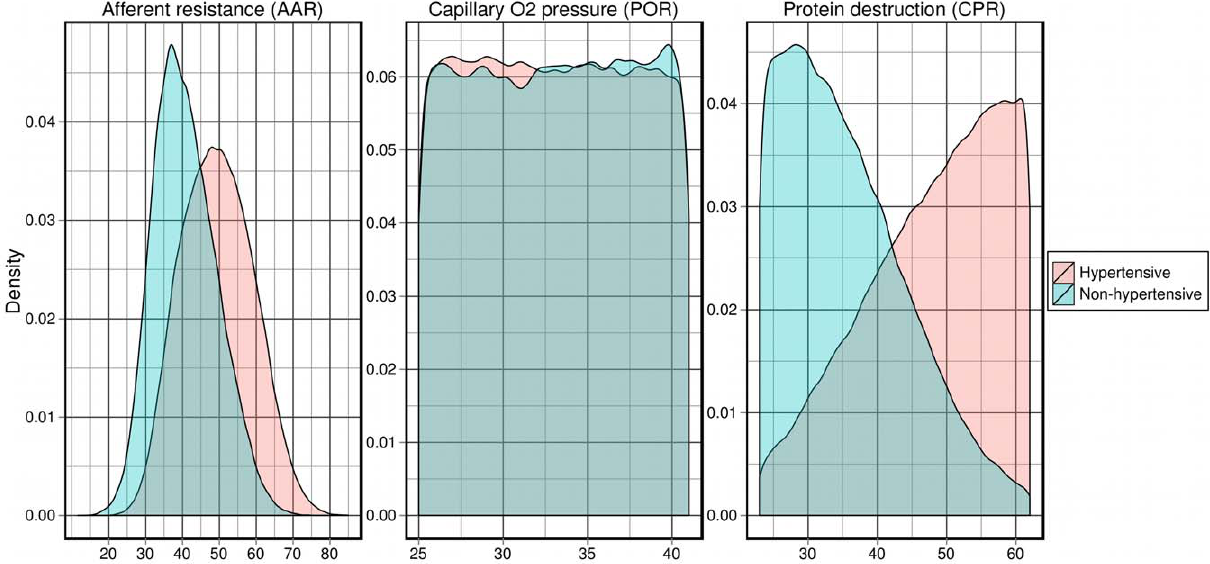
Figure 6. Probability densities of model variables in the normotensive and hypertensive virtual sub-populations. Probability densities are shown for AAR (the afferent arteriolar resistance), POR (the reference value of capillary O 2 pressure in non-muscle tissue) and CPR (the critical plasma protein concentration for protein destruction).